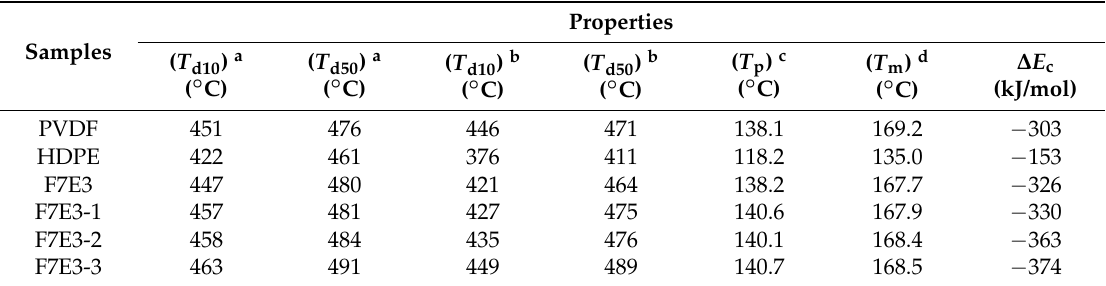
Table 3. Thermogravimetric analysis (TGA) and differential scanning calorimeter (DSC) data of selected